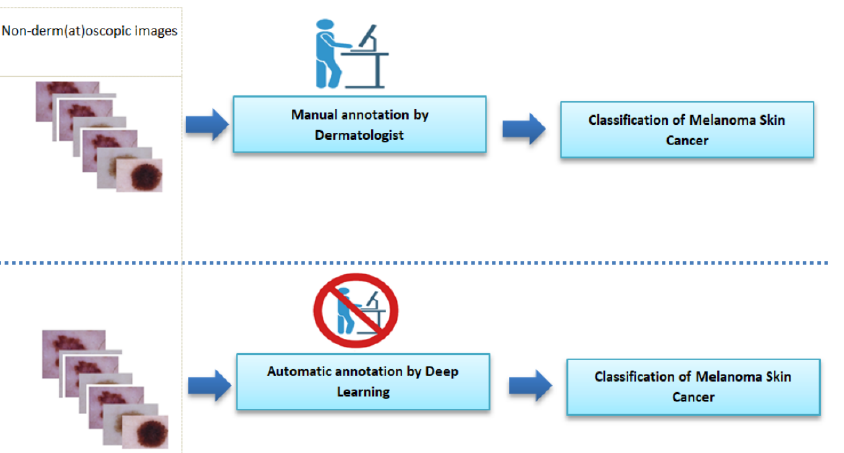
Figure 2. Comparison of the stages of the manual diagnostic process and the diagnostic process based on deep learning technology. Figure created with